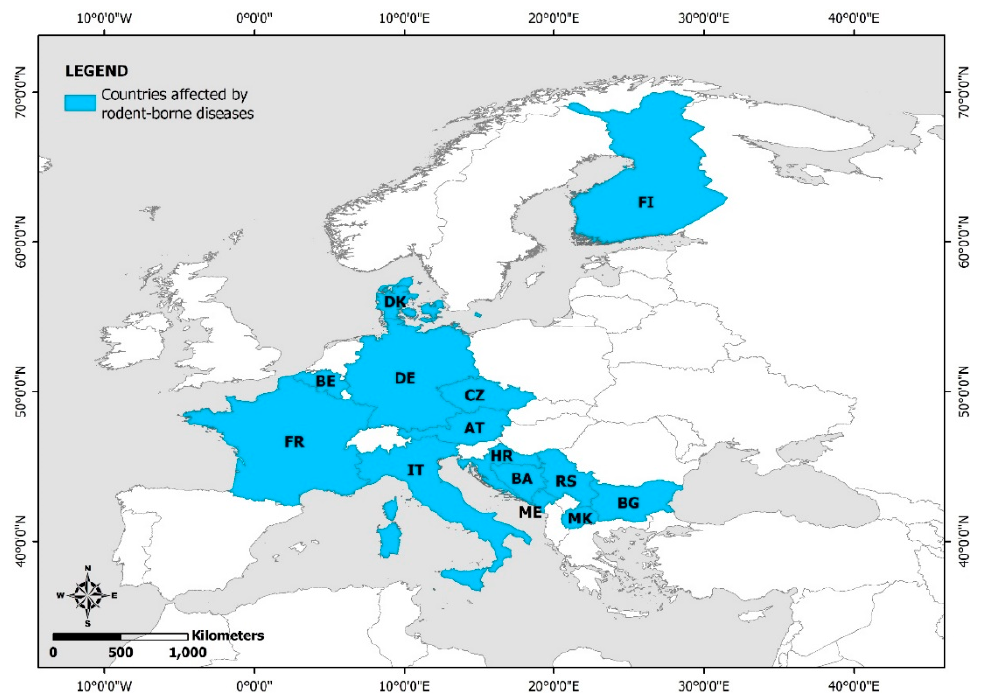
Figure 4. European countries with reported flood-related rodent-borne diseases (FI: Finland; DK: Denmark; FR: France; BE: Belgium; DE: Germany; CZ: the Czech Republic; AT: Austria; IT: Italy; HR: Croatia; BA: Bosnia and Herzegovina; RS: Republic of Serbia; ME: Montenegro; MK: North Macedonia; BG: Bulgaria).